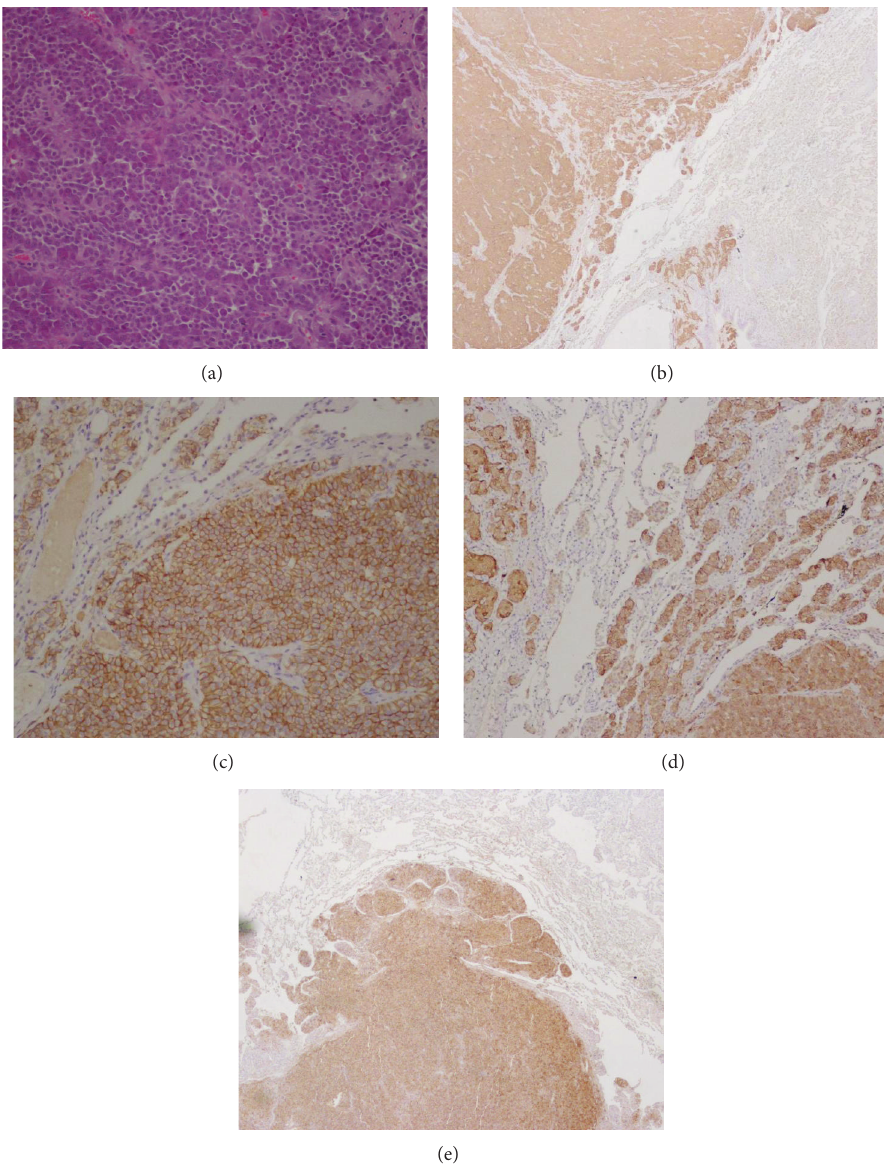
Figure 4: Histology. (a) Hematoxylin-eosin staining, × 10: organoid and trabecular pattern. (b) Positive immunoreactivity to chromogranin. (c) Positive immunoreactivity to synaptophysin. (d) Positive immunoreactivity to NCAM. (e) Positive immunoreactivity to